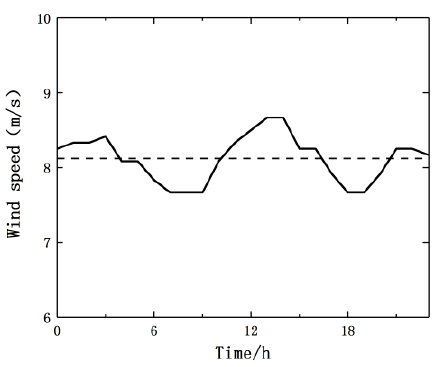
Figure 5. Typical day wind speed.